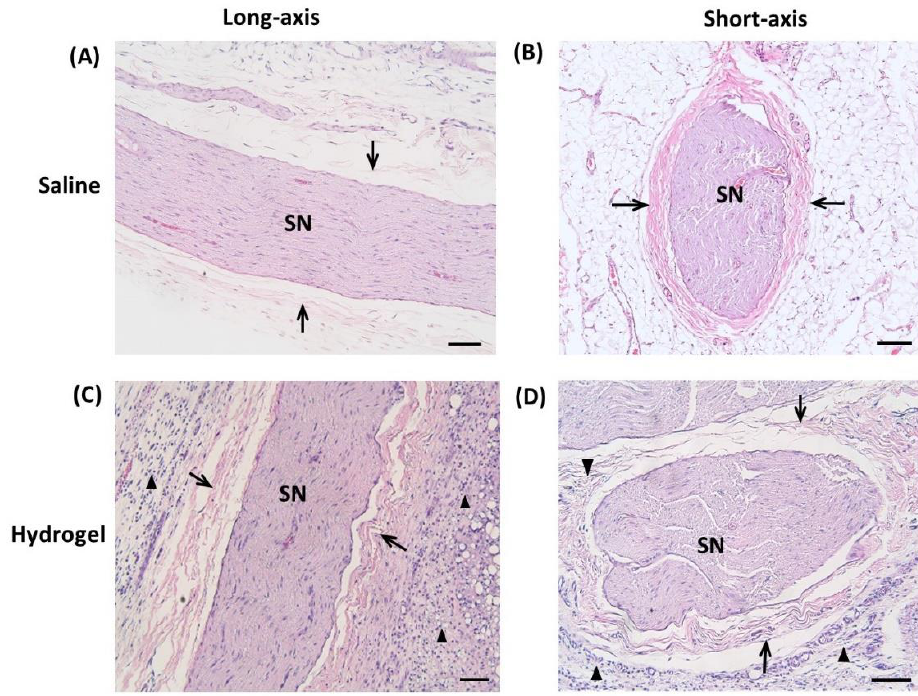
Figure 4. Representative micrographs of hematoxylin and eosin (H&E) stained sciatic nerve (SN) 14 days after injection of normal saline ( A , B ) and hydrogel ( C , D ). There is prominent cellular infiltration (arrowheads) surrounding epineurium (arrows) in the hydrogel-injected group with an irregular alignment of neural fascicles (scale bar: 100 μm).